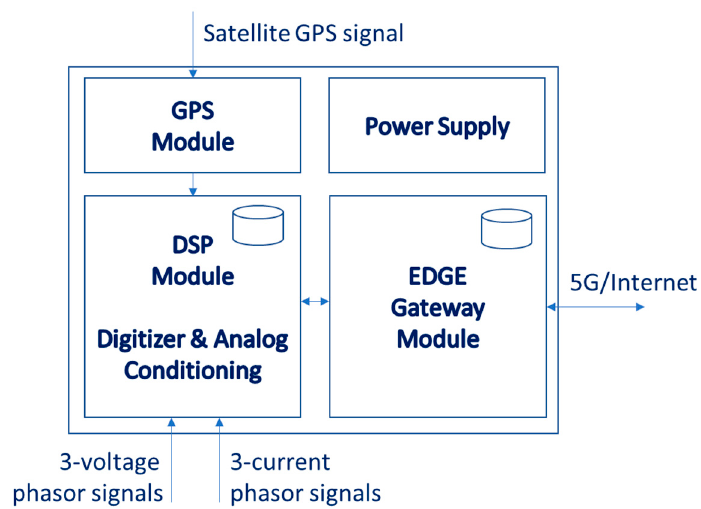
Figure 1. High-level architecture of the OpenEdgePMU system.